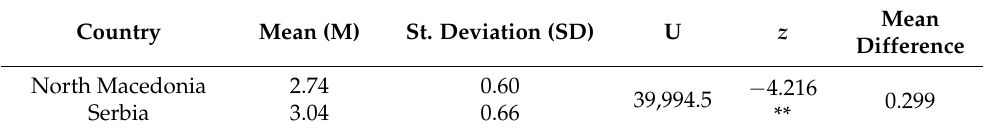
Table 5. Perceived mental effort during knowledge test.